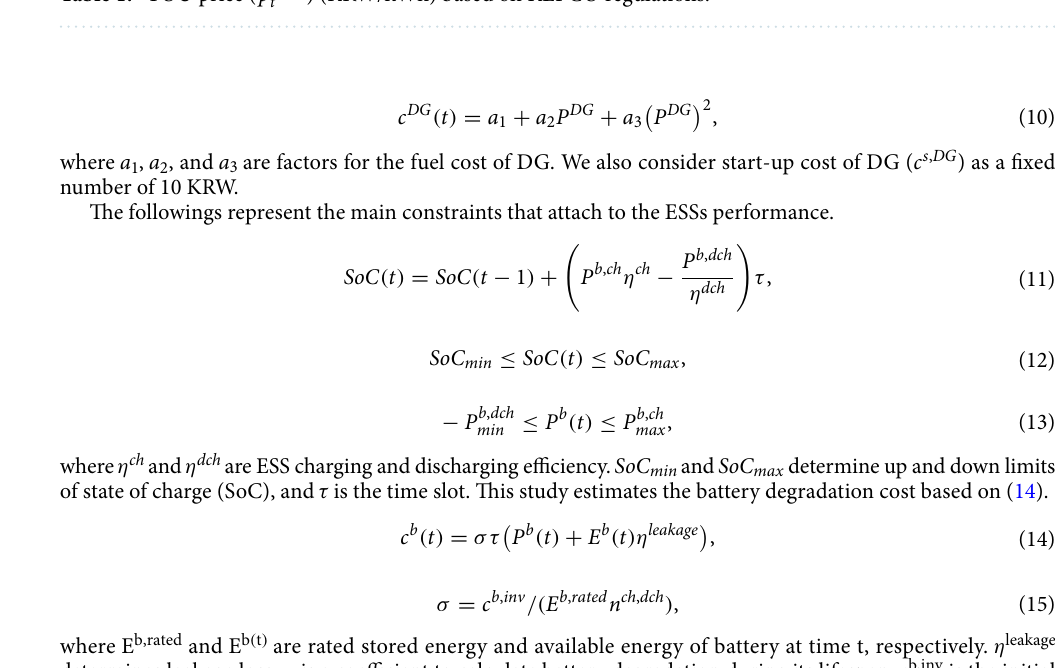
Table 1. TOU price ( p TOU t ) (KRW/kWh) based on KEPCO